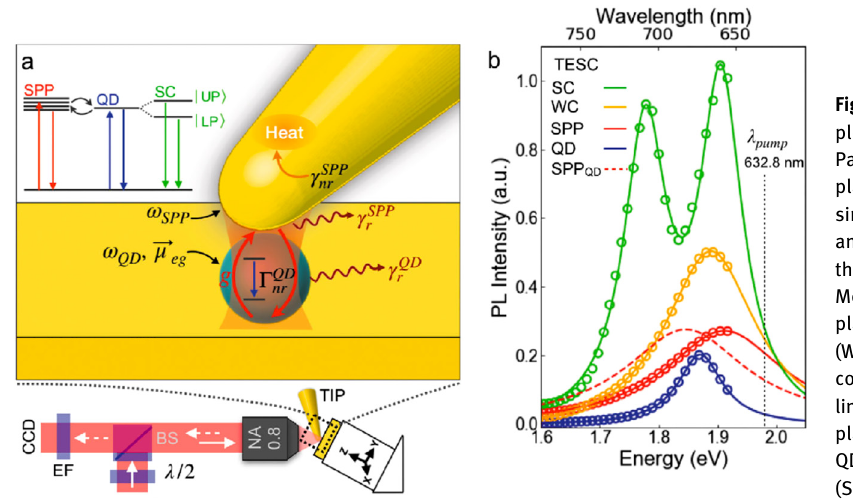
Figure 8: Tip-enhanced spectroscopy of plexcitons. Panel A: the strongly confined ∣ E z ∣ fi eld in a plasmonic nanogap cavity surrounding a singleisolatedCdSe/ZnSquantumdot(QD) and a tilted Au tip induce coupling between the plasmon and exciton. Panels B: Measured PL spectra for the QD, cavity plasmon polariton, weakly coupled system (WC) and strongly coupled states (SC) with couplingstrength g =141meV.ALorentzian lineshape representing the redshifted plasmon resonance in the presence of the QD is calculated from the fi tted values (SPP QD ) [398].